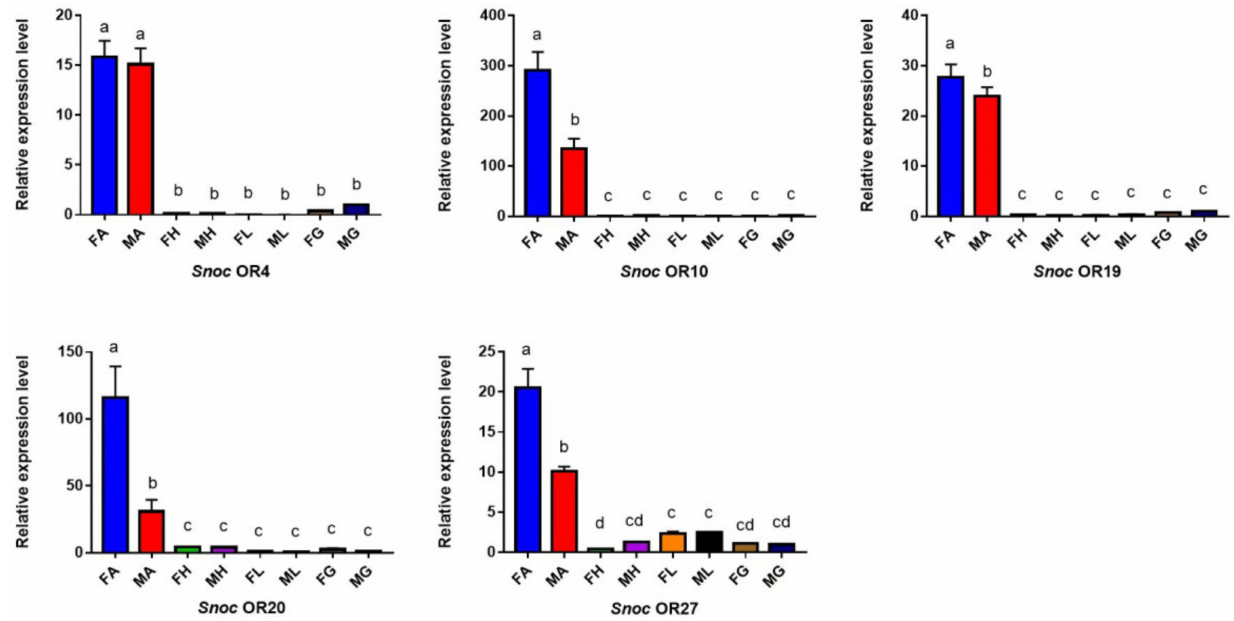
Figure 6. Relative expression of S. noctilio and S. nitobei ORs in different parts of female and male adults by qPCR. FA: female antennae; MA: male antennae; FH: female head; MH: male head; FL: female legs; ML: male legs; FG: female genitals; MG: male genitals. The standard error was represented by the bar and the significant differences ( p < 0.05) were indicated by different small letters (a–e) above each bar. N/A indicates that the transcript level is too low to measure.